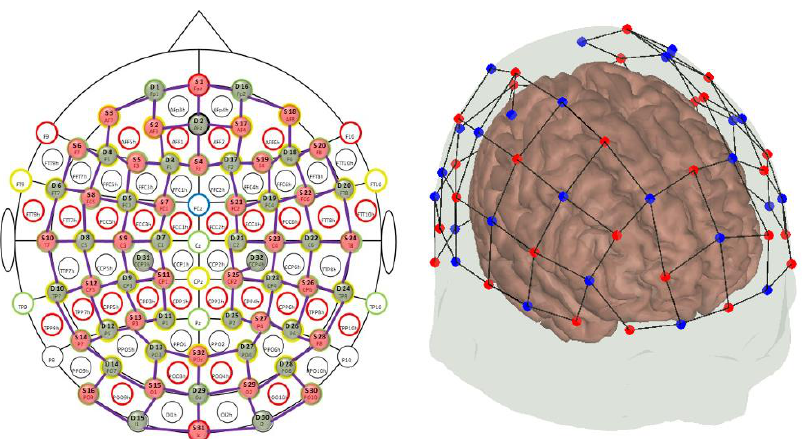
Figure 1. Employed fNIRS probe configuration in the current study. ( Left ) Red and green dots indicate the respective location of LED sources and fiber optics detectors according to the 10–10 reference system labeling. ( Right ) Virtual co-registration of source (red dots) and detector (blue dots) locations over the Colin27 anatomical template in the AtlasViewer software package [45].